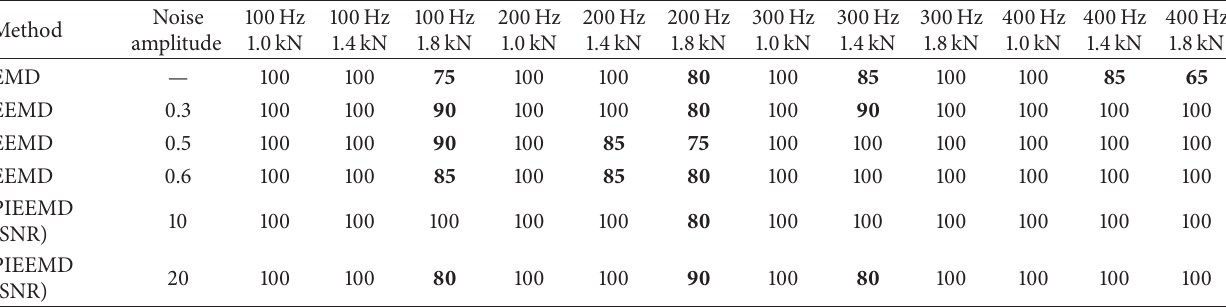
Table 5: The reliability test of the constructed SVM with 20 new samples ( 𝑌